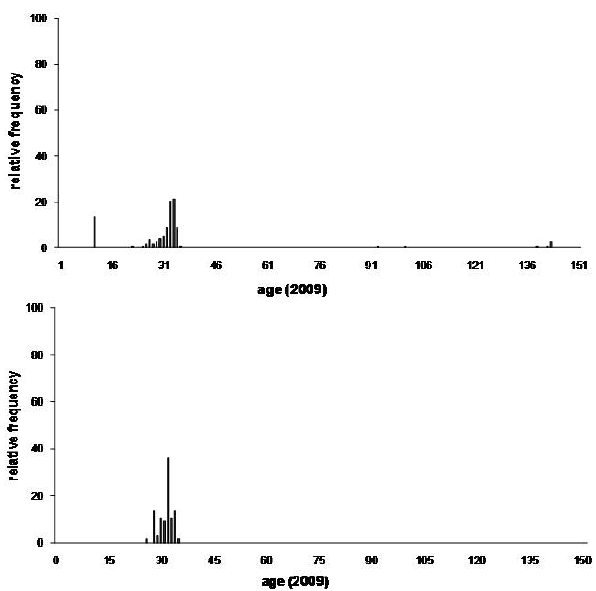
Fig. 7. Frequency distribution of ages for shrubs sampled in the both study sites. (A) Fire site. (B) Control site.